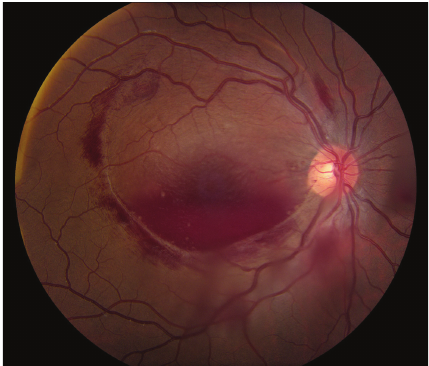
Figure 3: Color fundus photo of the right eye 10 days after presentation. The preretinal hemorrhage has spontaneously drained in the vitreous.